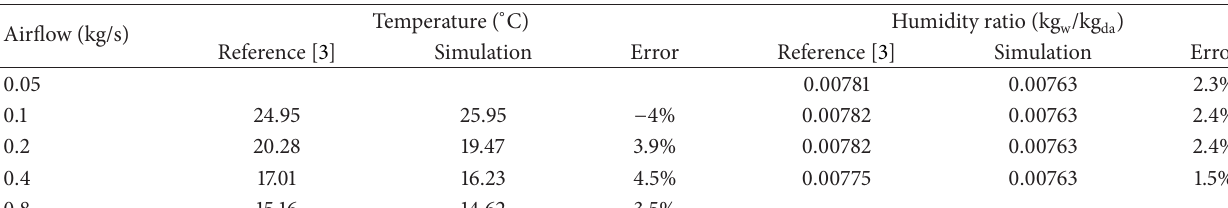
Table 2: Steady state of zone versus air mass flow rate.